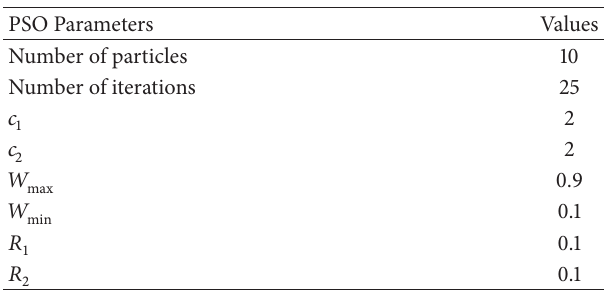
Table 3: Values of PSO parameters.